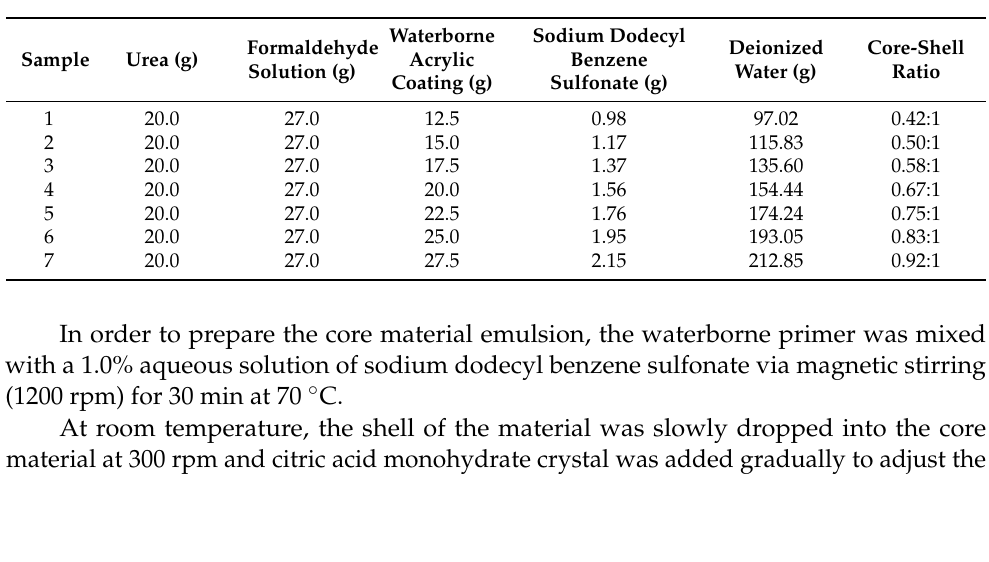
Table 1. Proportion of the raw